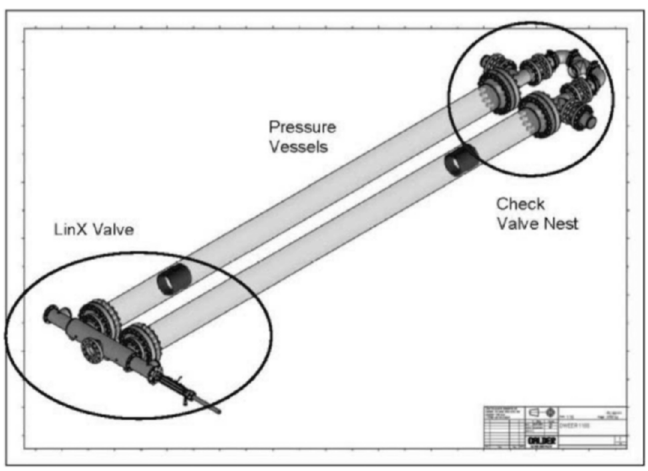
Figure 2. The DWEER TM work exchanger [ Error! Reference source not found. ].